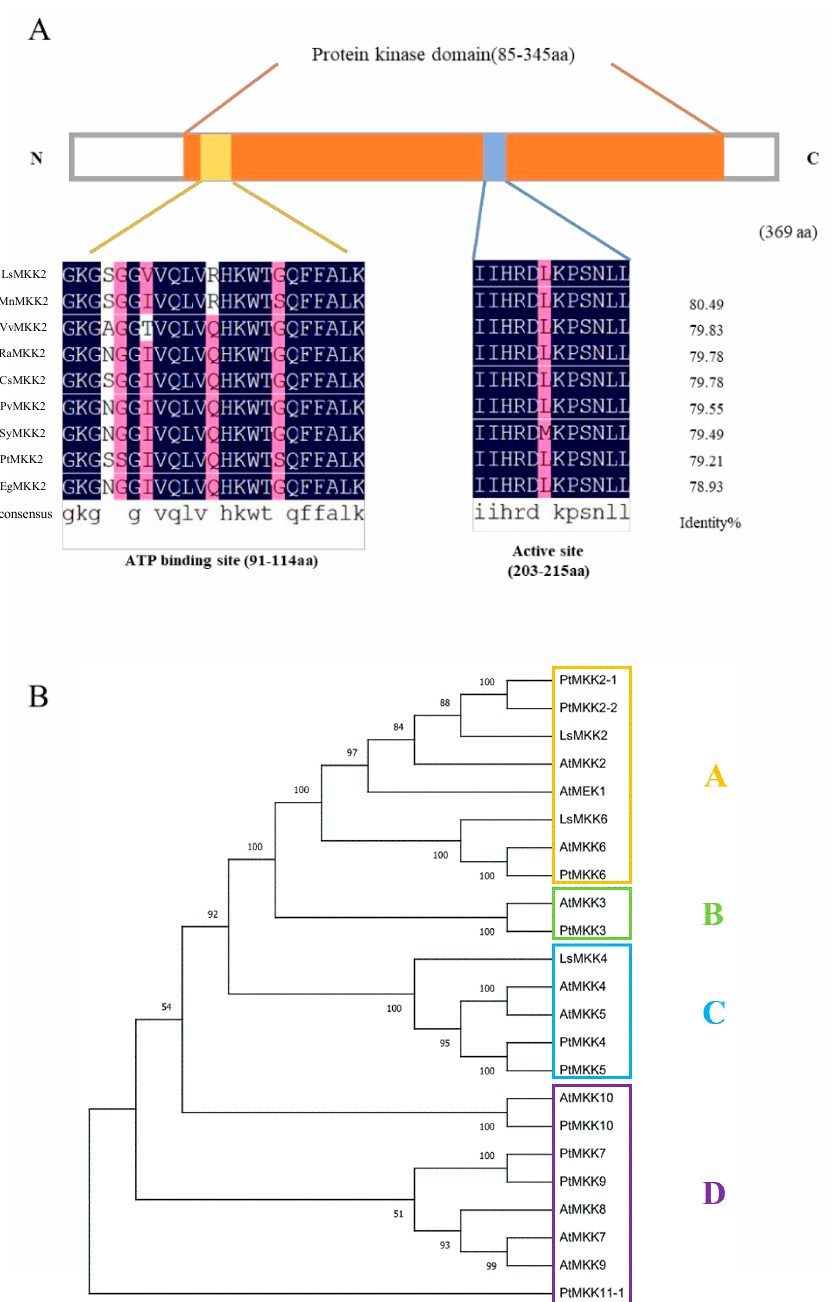
Figure 1. Phylogenetic relationship of LcMKKs with AtMKKs and PtMKKs. ( A ) Multiple alignment using the conserved protein domains of MKK2 orthologs from L. chinense and two other plant species. ( B ) The MAPKK family genes in Arabidopsis and P. trichocarpa are divided into four subfamilies (here, denoted as A, B, C, and D); each subfamily is indicated by a uniquely colored box. At, A. thaliana ; Pt, P. trichocarpa .